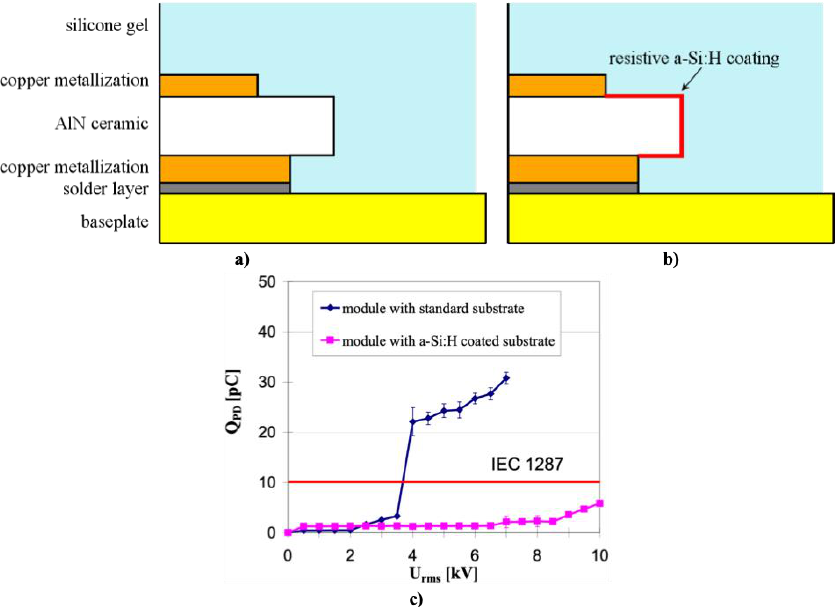
Figure 2. IGBT modules ( a ) without ( b ) with resistive a-Si:H coating. ( c ) Comparison of the PD of both modules. © 2021 IEEE. Reprinted, with permission, from Ref. [3].